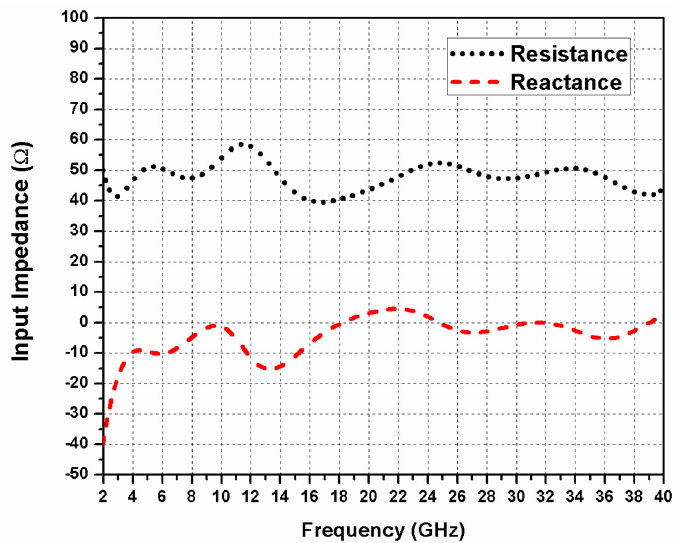
Figure 4. Input impedance of the SWB antenna.